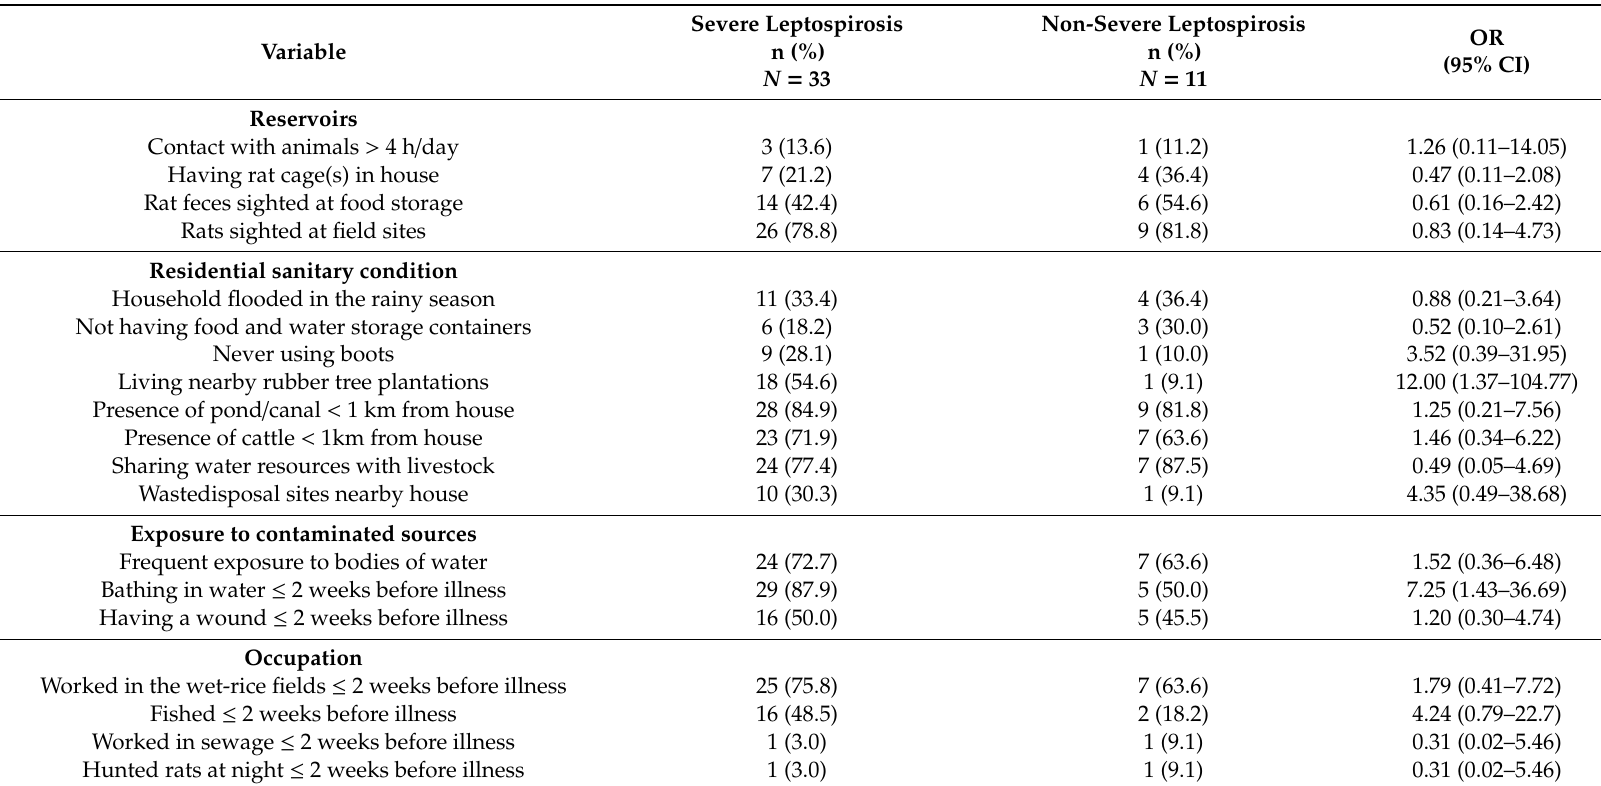
Table 3. Odds ratios and 95% confidence intervals of risk factors for severe leptospirosis from 12 hospital-based sites, Thailand 2017.